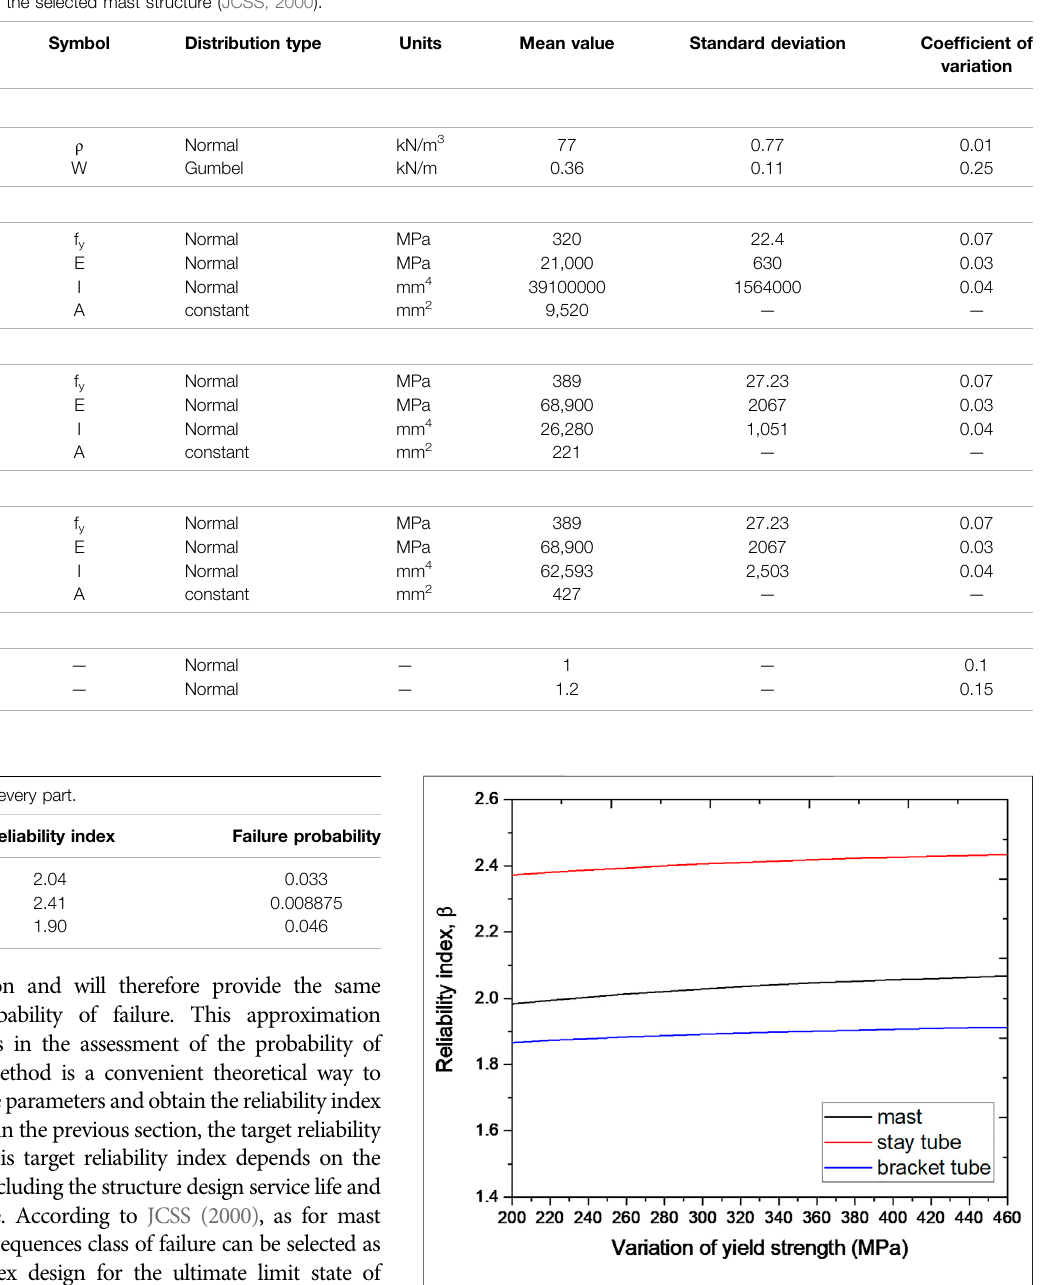
FIGURE 4 | Effect of yield strength variation on reliability